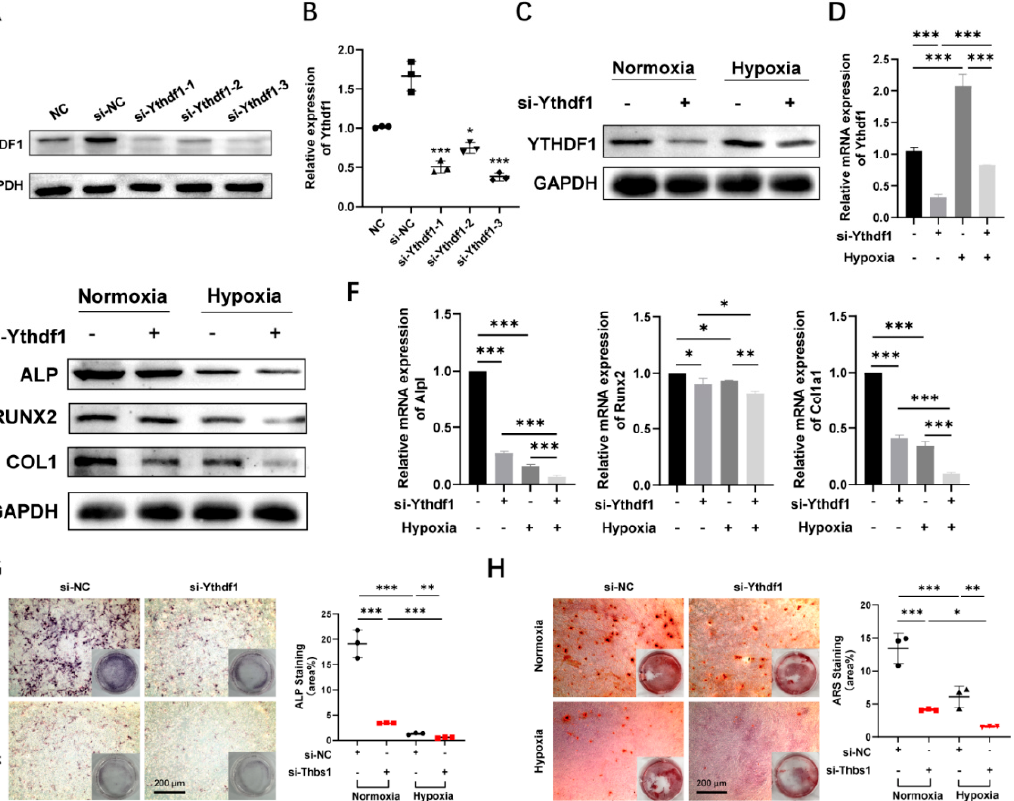
Figure 2. YTHDF1 promotes osteogenic differentiation under normoxic and hypoxic conditions. ( A,B ) YTHDF1 protein and mRNA expression determined through qRT-PCR and Western blot after 48 h transfection of siRNAs or negative control in MC3T3-E1 cells. ( C,D ) Protein and mRNA expressions of YTHDF1 in MC3T3-E1 cells transfected with silenced YTHDF1 were detected after 24 h cultured under hypoxia (1% O 2 ). ( E,F ) mRNA and protein expression levels of ALP, RUNX2, and COL1 after transfected with silenced YTHDF1 were confirmed with qRT-PCR and Western blot in comparison with si-NC. ( G,H ) Examples of ALP versus ARS staining showed the inhibitory effect of knocking down YTHDF1 on differentiation of MC3T3-E1 osteoblasts cultured in the osteogenic